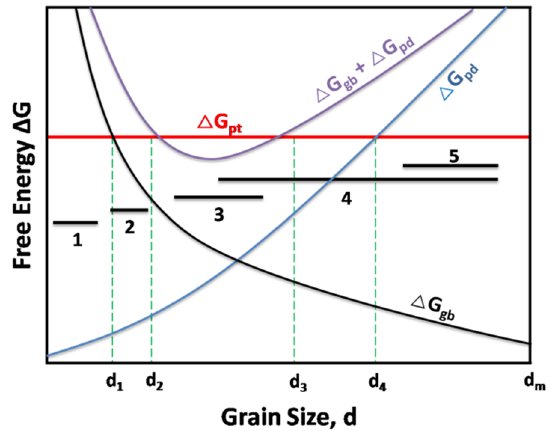
Figure 2. Schematic descriptions for the free energy of point defects ( ∆ G pd ), grain boundaries ( ∆ G gb ) and phase-transition ( ∆ G pt ) in irradiated nanostructured materials as a function of grain size (d) [38]. The intra-grain defect clusters in NS materials are strongly dependent on the grain